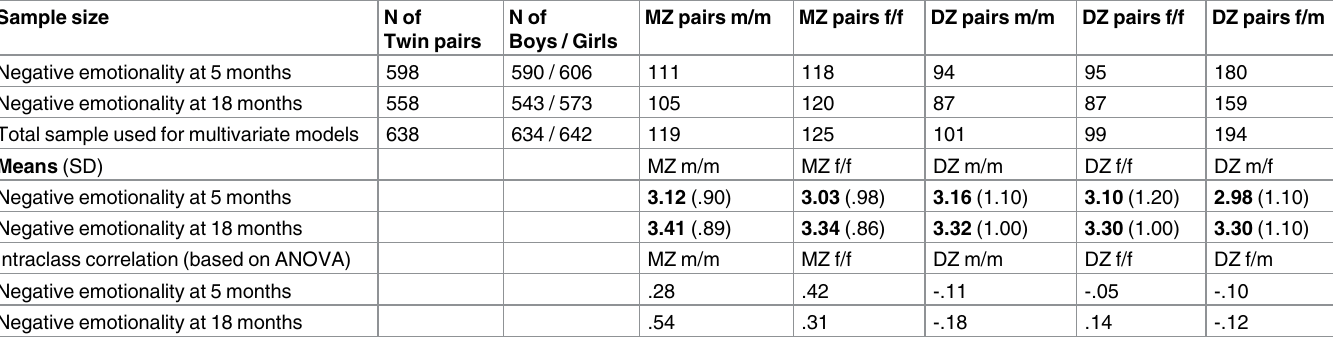
Table 2. Sample size, means and intraclass correlations of twins at 5 and 18 months separated by sex and zygosity. Sample size